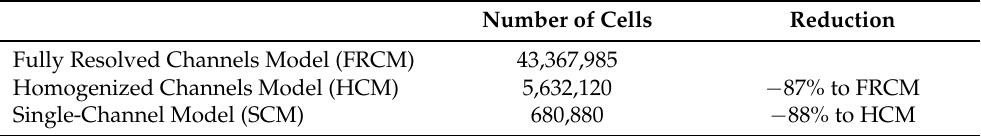
Table 4. Comparison of total number of computational cells of the resulting